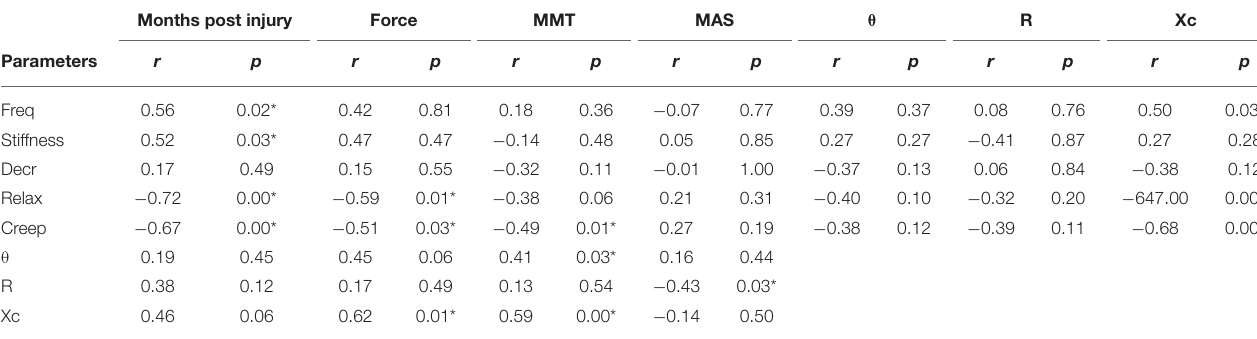
TABLE 2 | The results of correlation analysis between myotonometer, electrical impedance myography (EIM), and dynamometer. Months post injury Force